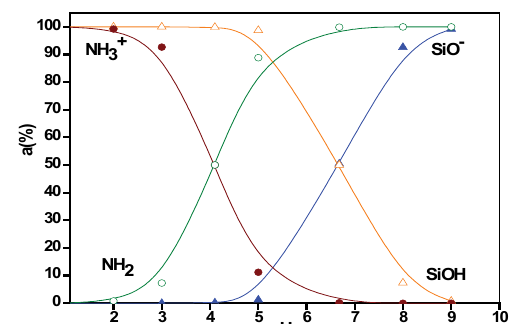
Figure 6. Distribution diagrams of silanol and aminopropyl groups as a function of pH for adsorbents 1 and